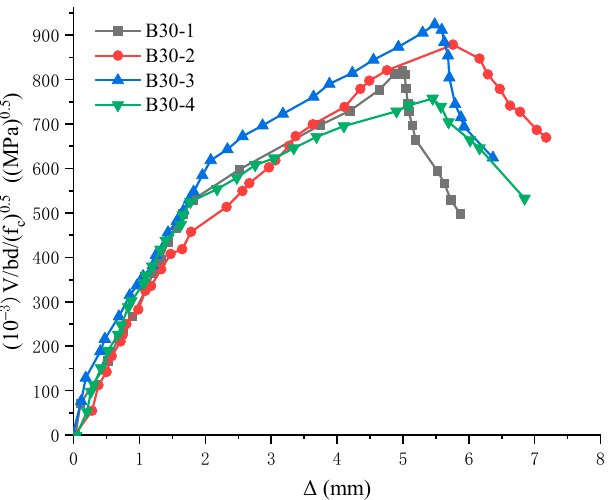
Figure 8. Effect of post-filling coarse aggregate ratio (PFR) on load–deflection response for C30 concrete.